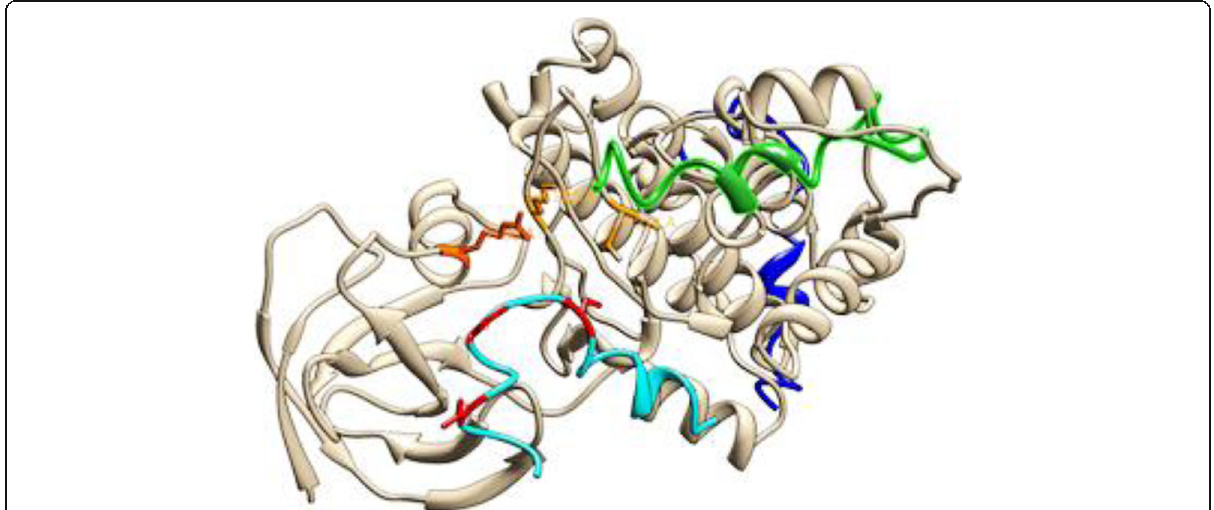
Fig. 6 Molecular docking complex of CTNNB1 MT (S33F and T41A) with GSK3. Interaction of GSK3 and its substrate of CTNBB1 motif. The cyan color show the wild motif, green show mutant S33F and blue showed the mutant T41A. The red color sticks represents interacting residue of CTNBB1 and interacting residue of GSK3 are shown in orange sticks